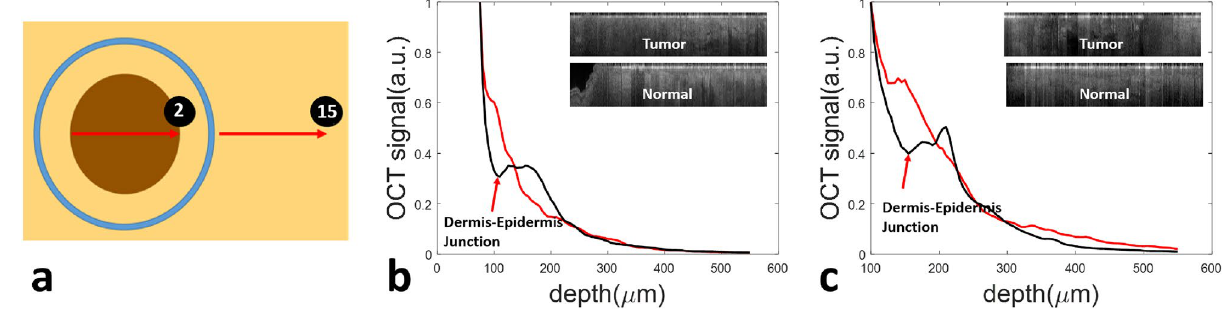
Figure 8. ( a ) OCT data obtained from the tumor (scan2) and adjacent normal tissue (scan15); ( b ) Depth profiles of the tumor (red) and adjacent normal skin (black) for Patient 1; ( c ) Depth profiles of the tumor (red) and adjacent normal skin (black) for Patient 2. In normal skin of both ( b ) and ( c ), the signal corresponding to the DEJ forms a depression in the black curve, which is absent in the tumor